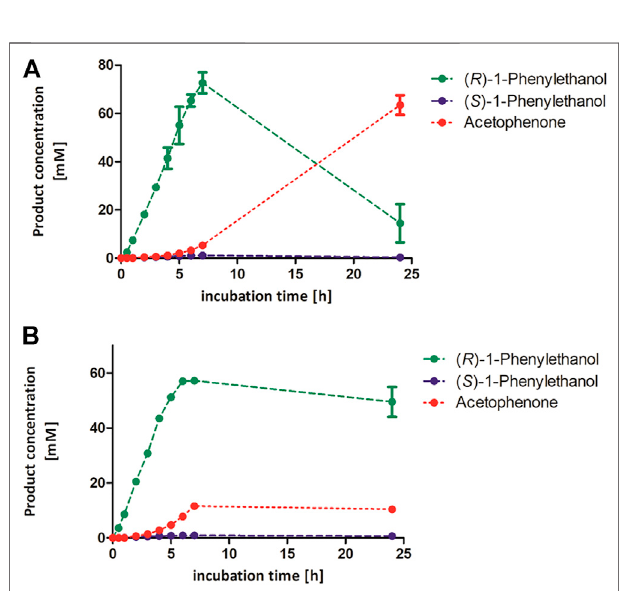
FIGURE 5 | Product concentrations during conversion of 100 mM ethylbenzene by r Aae UPO applying 50 vol% (A) or 80 vol% acetonitrile (B) . Reaction conditions: 100 mM potassium phosphate buffer, pH 6.0, 1 µM r Aae UPO(concentrated supernatant),and H 2 O 2 -dosingrate:8 mM h − 1 . The concentration of both 1-phenylethanol enantiomers and acetophenone werecalculatedbasedonacalibrationcurverecordedearlier.Duplicates.GC- analysis was performed on the chiral column (CP-Chirasil-Dex CB).